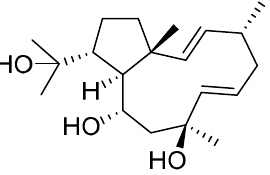
Figure 17. Structure of (1 R ,2 E ,4 R ,6 E ,8 S ,10 S ,11 S ,12 R )-8,10,18-trihydroxy-2,6-dolabelladiene ( 41 ).